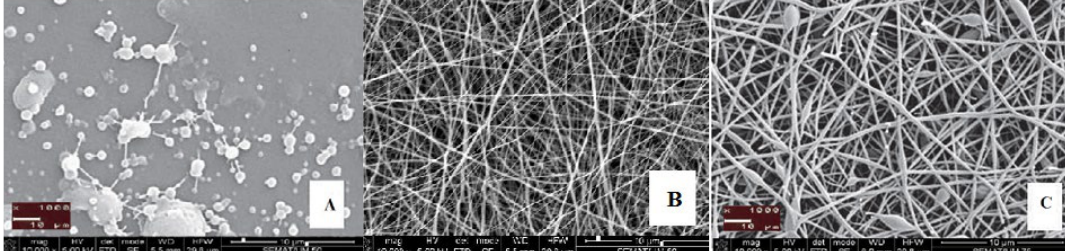
Fig. 2: SEM of Bassorin (A), Nanofibers of PEO 6.5% (B) and Nanofibers of Bassorin/PEO (C) (Magnification of all Fig.s 1000X) Figure 2: SEM of Bassorin (A) , Nanofibers of PEO 6.5 % (B) and Nanofibers of Bassorin/PEO (C) (Magnification of all figures 1000X )